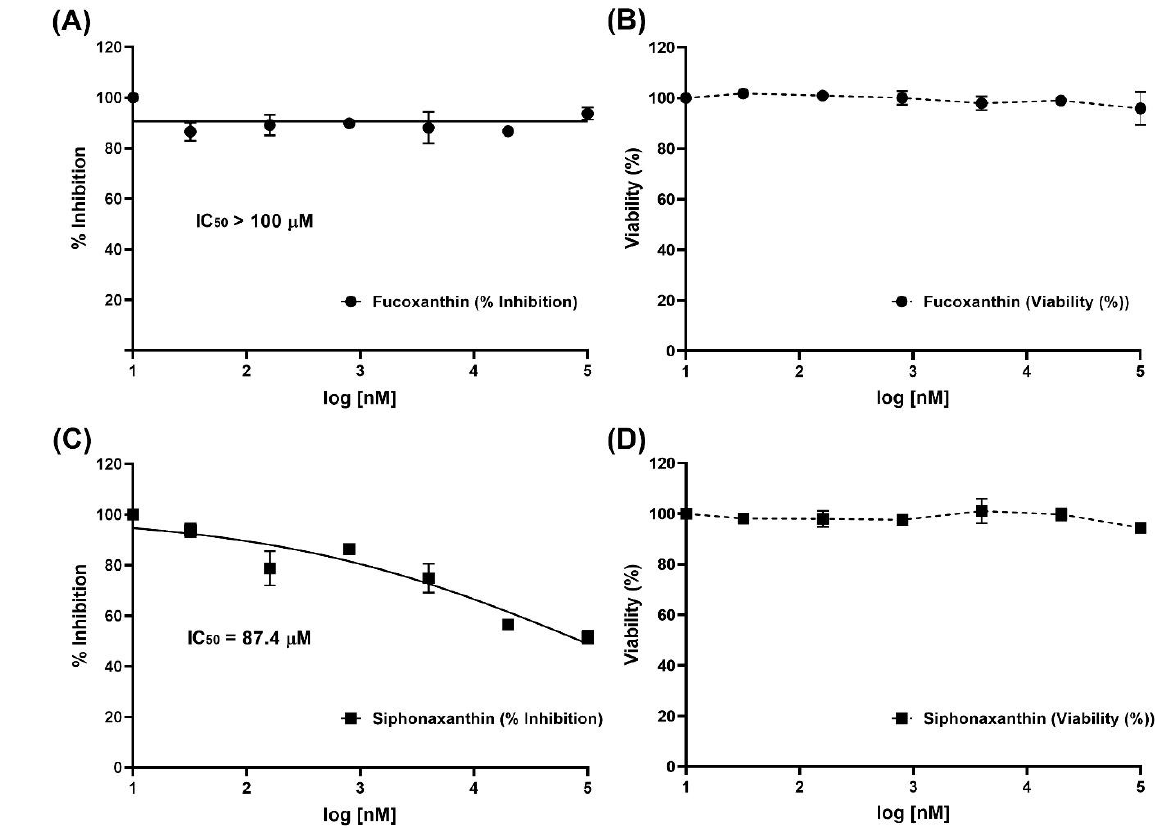
Figure 4. Determination of the cytotoxicity and antiviral activity of the fucoxanthin and siphonaxanthin in HEK293/ACE2 cells. The inhibition of viral infection by the ( A ) fucoxanthin and ( C ) siphonaxanthin was performed with SARS-CoV-2 pseudovirus containing the S-glycoprotein of SARS-CoV-2 (COVID-19). The viability of HEK293/ACE2 cells was assessed using an CellTiter-Glo ® Luminescent cell viability assay kit (Promega, Madison, WI, USA) after treatment with the indicated concentrations of the ( B ) fucoxanthin and ( D ) siphonaxanthin for 96 h. Results are expressed as percent of inhibition in drug-treated cultures compared with untreated and was plotted with GraphPad Prism software (Graph-Pad, San Diego, CA, USA). Values are the means ± S.D. ( n = 3).